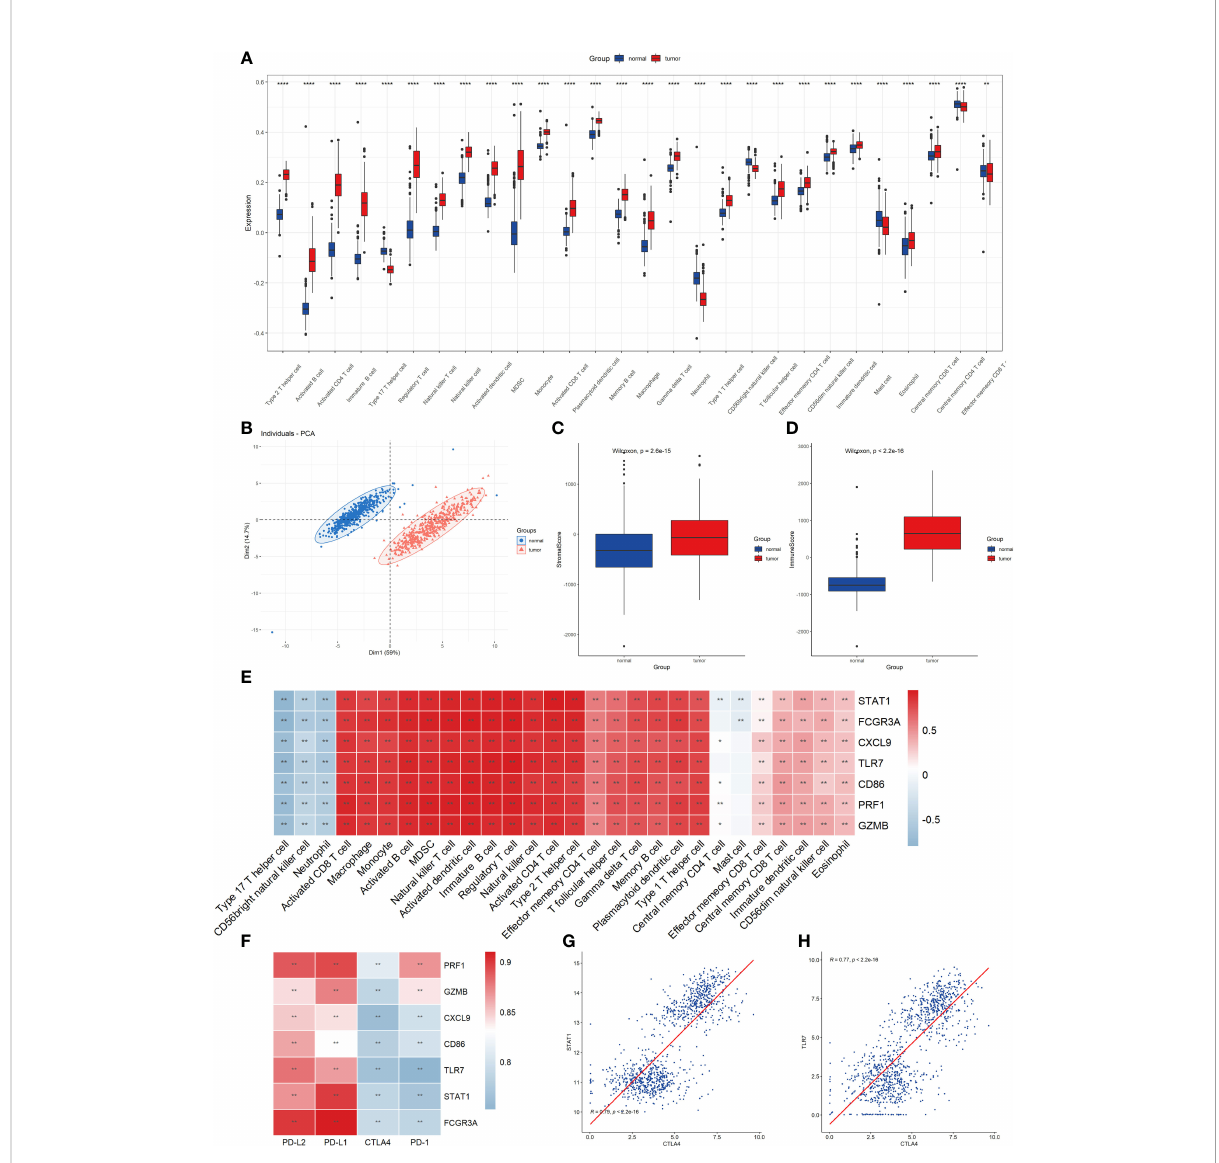
FIGURE 5 Evaluation of 28 TME immune cell in fi ltration characterization. (A) Differences in 28 TME in fi ltration cells between normal skin and cutaneous melanoma (** P < 0.01, **** P < 0.0001). The results showed that all immune cells were signi fi cantly different between the two types of samples. (B) Principal component analysis. The results demonstrated that the two separate taxa, suggesting there existed signi fi cantly differences in the landscape of 28 TME immune cell in fi ltration between normal skin and cutaneous melanoma. (C) Difference in StromalScore between normal and tumor tissues using ESTIMATE algorithm. (D) Difference in ImmuneScore between normal and tumor tissues using ESTIMATE algorithm. (E) The correlation between seven key molecule and each TME in fi ltration cell type. The results showed a strong correlation between them, red represents positive and blue represents negative. (* P <0.05, ** P <0.01) (F) The correlation between the seven key molecules and four immune checkpoint molecules. The results demonstrated a strong correlation between them. (** P <0.01) (G) The correlation between STAT1 expression and CTLA4 expression. (H) The correlation between TLR7 expression and CTLA4